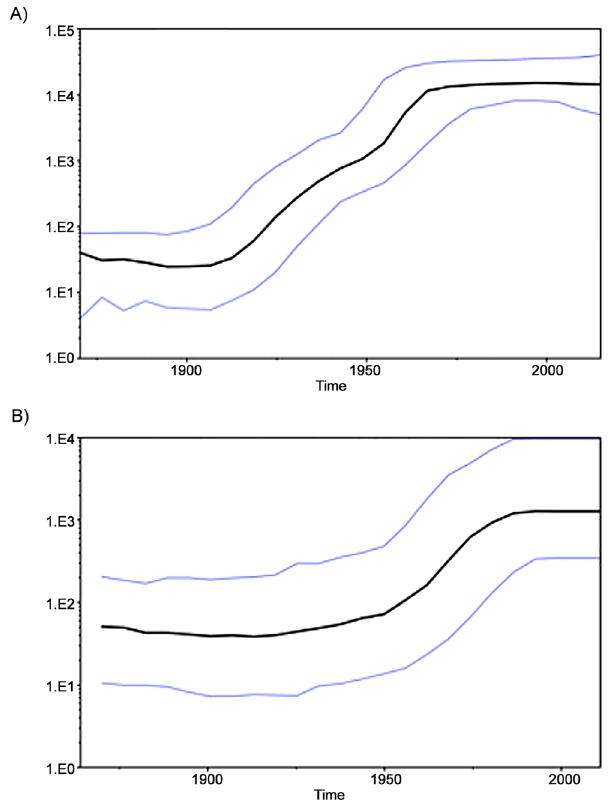
Fig 3. Bayesian Skyline Plots for Demographic Reconstruction using NS5B sequences. A) subtype 2c, B) subtype 2k; X-axis: Date in Years; Y-axis: Estimated effective number of infections; Bold Line: Mean Effective Number of viral population. Upper and lower Lines: Upper and Lower HPD95% (High Population Density) of Effective Number of viral population.